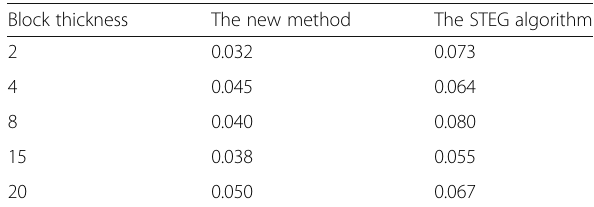
Table 3 Experimental time of gauge blocks measurement (unit: